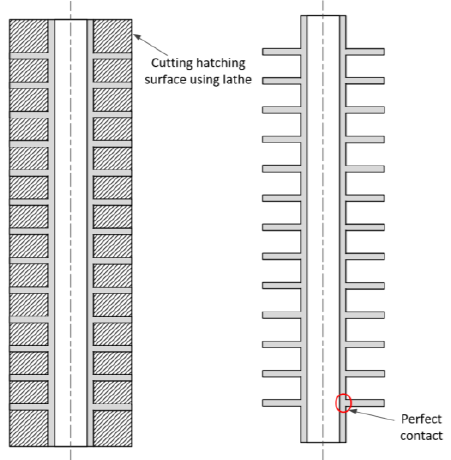
Figure 4. Fabrication process of the annular finned tube in this work.